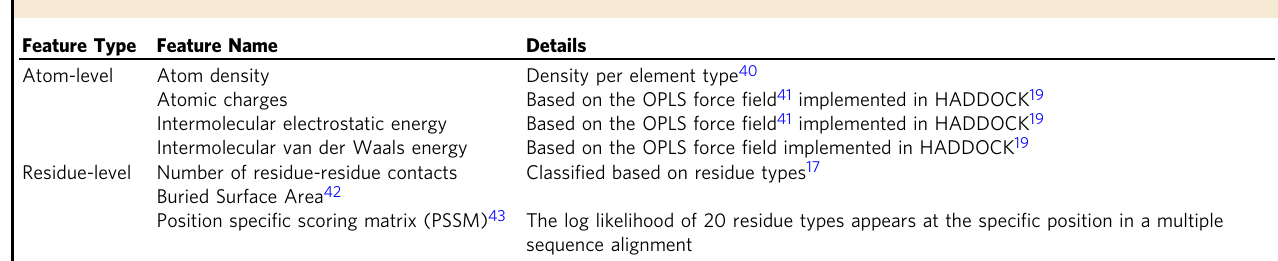
Table 1 Interface features prede fi ned in